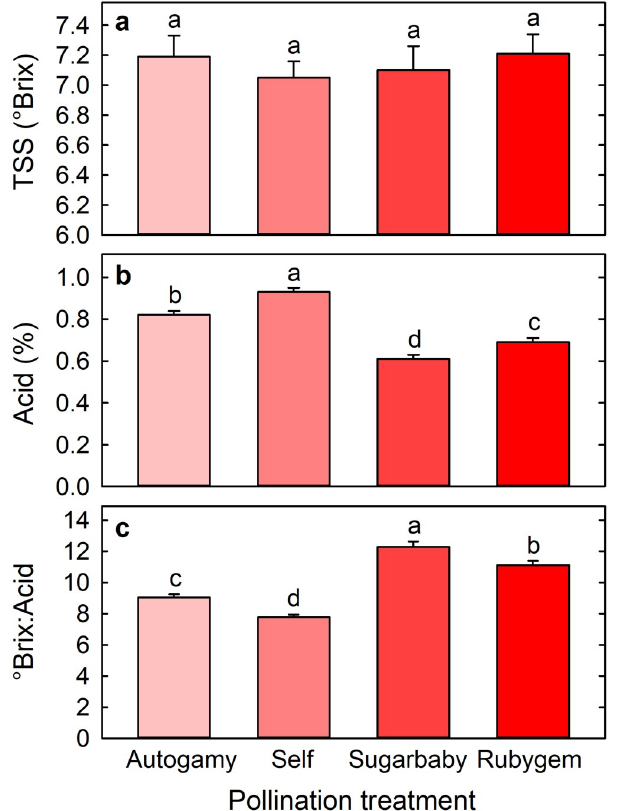
Fig 4. (a) Concentration of total soluble solids (TSS; ˚Brix), (b) acid (%), and (c) ˚Brix:acid ratio of Redlands Joy strawberry fruit arising from unassisted self-pollination (Autogamy) or hand-pollination with self-pollen (Self) or cross-pollen from another cultivar (Sugarbaby or Rubygem). Means + SE with different letters are significantly different (GLM; P < 0.05; n = 99–100 fruit).